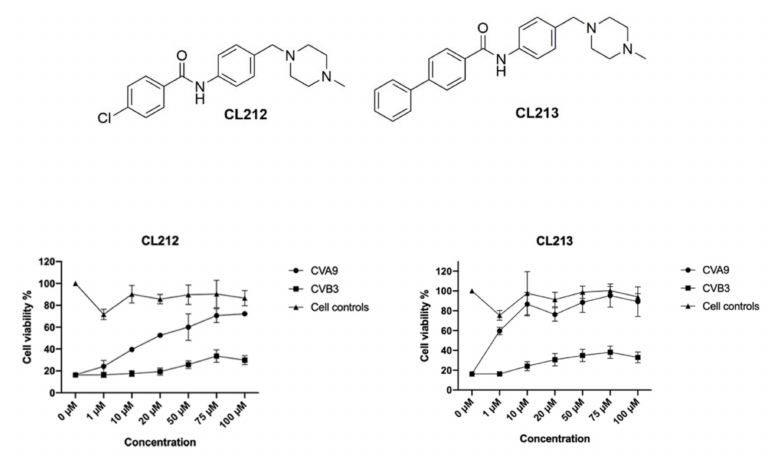
Figure 1. CL212 and CL213 rescue A549 cells from CVA9 infection. The viruses (1.6 × 10 7 PFU/mL) were pre-treated with the molecules (CL212 or CL213) for 1 h at +37 ◦ C and the next virus/molecule mixture was added to cells (MOI 80). Also, cytotoxicity controls were included with no virus (cell controls). Cell viability was determined after 24 h using CPE assay (see details in materials and methods). Viabilities are presented as mean ± SEM from three repeats.